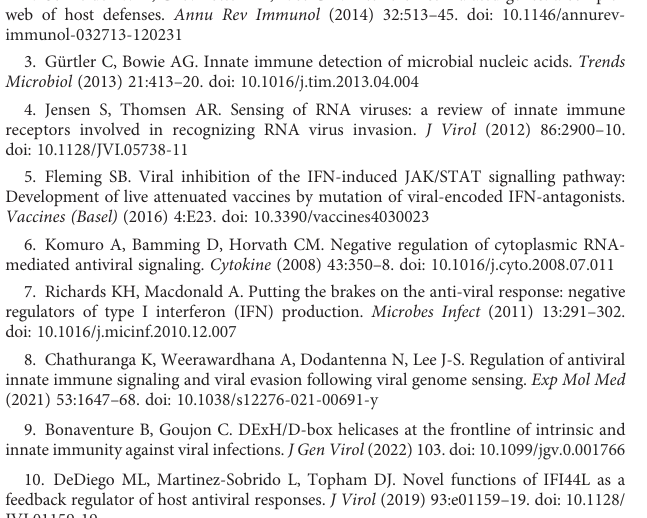
SUPPLEMENTARY FIGURE 1 Effect of IFI6 expression on viral replication in vivo . Mice (n=4/group) were infected with IAV-mCherry and IAV-IFI6 viruses (2,000 FFU/mice). At 1 and 2 dpi, viral titers in mouse lungs were evaluated by an immunofocus assay in MDCK